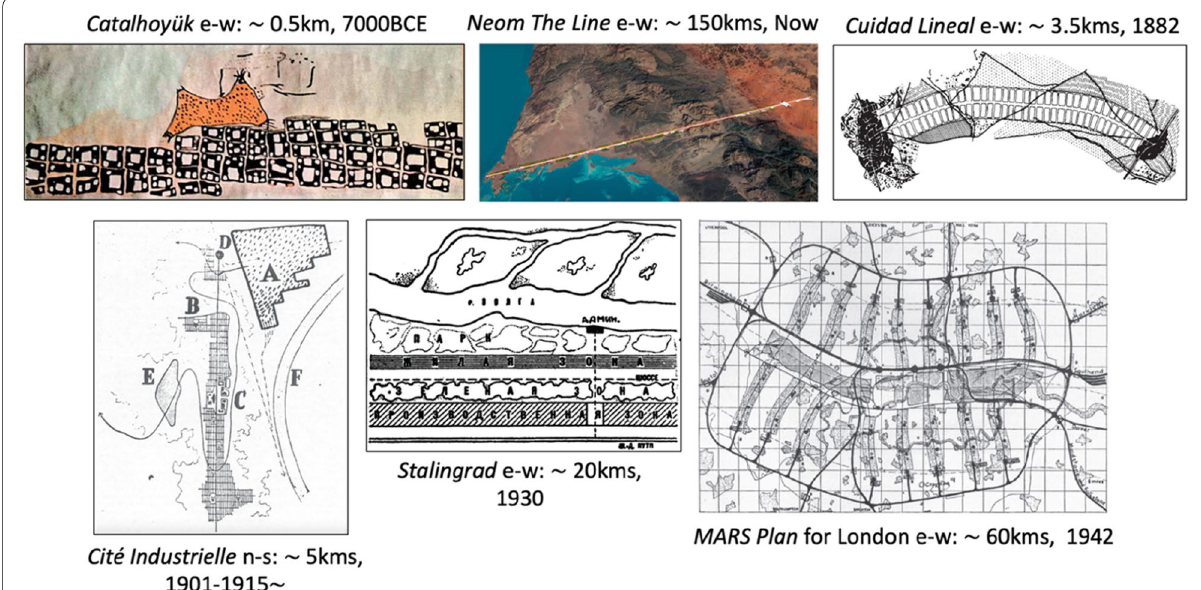
Fig. 2 A Sample of Linear Cities at Different Scales and